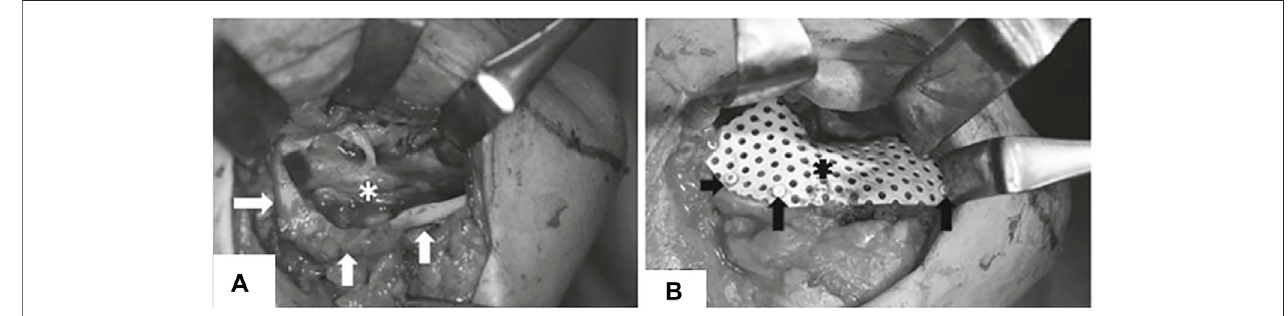
FIGURE 7 | Customized uHA-PLLA mesh in clinical usage. (A) Exposure of alveolar bone ridge. (B) Fixation of customized uHA-PLLA mesh. Reproduced with permission from Matsuo et al.